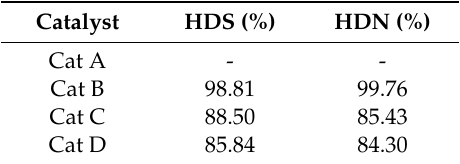
Table 1. Comparisons of the hydrodesulfurization (HDS) activity and hydrodenitrogenation (HDN) activity of the four NiMo / γ -Al 2 O 3